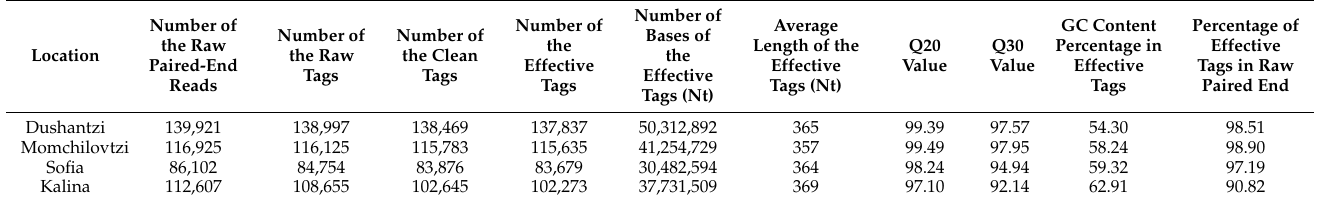
Table 1. Results from the NGS sequencing of the samples.